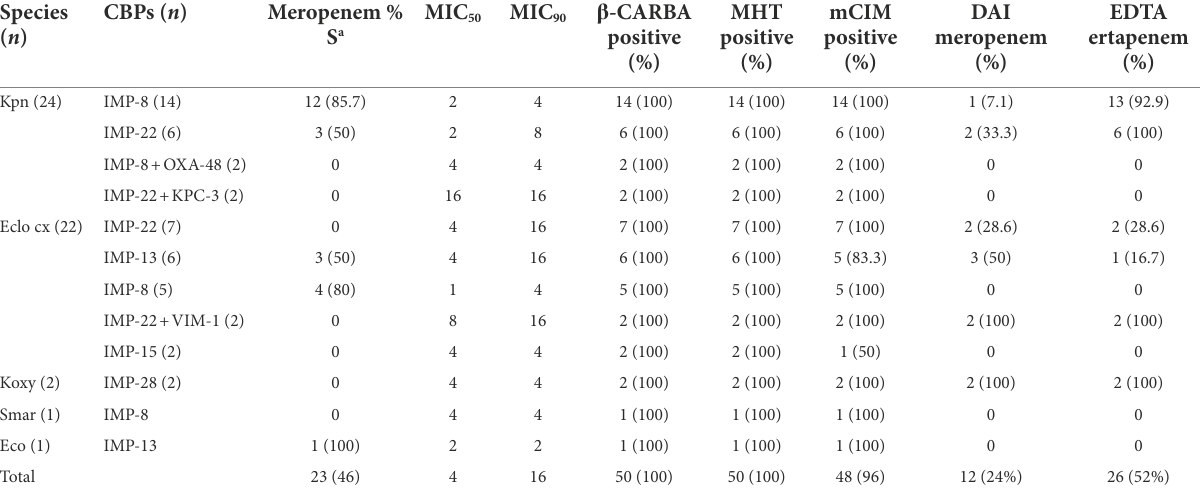
TABLE 2 Phenotypic features for detection of IMP production in IMP-producing Enterobacterales isolates. Species ( n